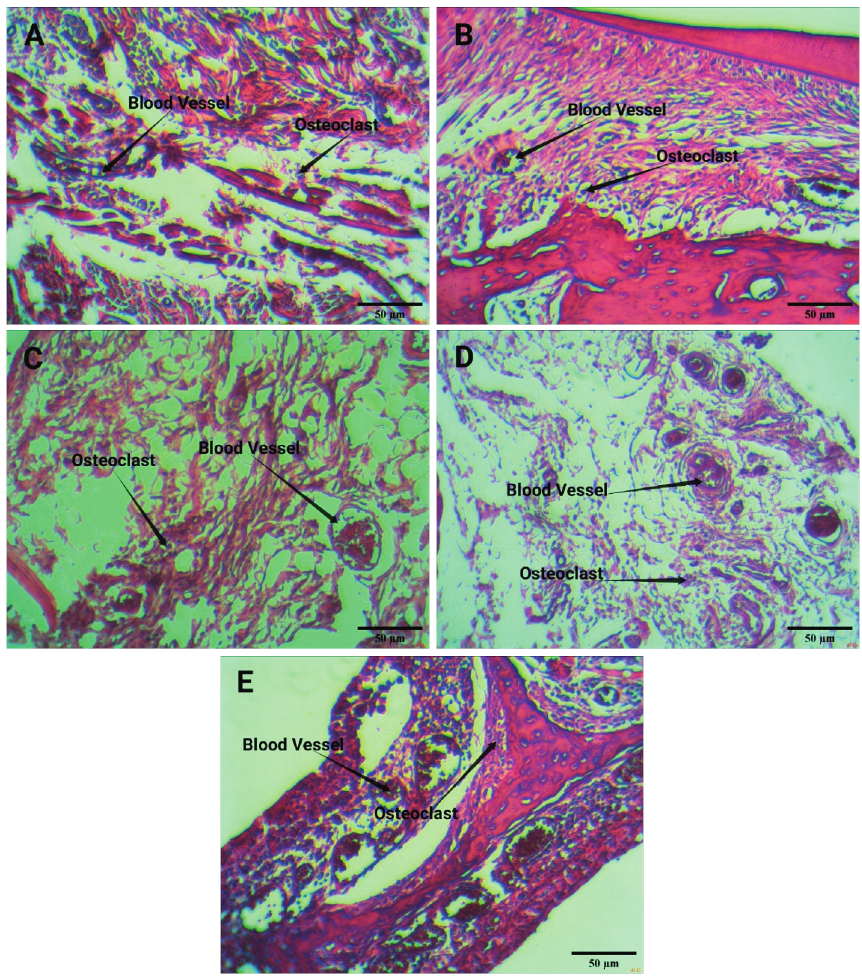
Figure 4: The result of HE staining. Blood vessels and osteoclasts in (a) the negative control, (b) the positive control, (c) caffeine 25mg/kg, (d) caffeine 50mg/kg, and (e) caffeine 75mg/kg. Scale bar: 50 µ m.